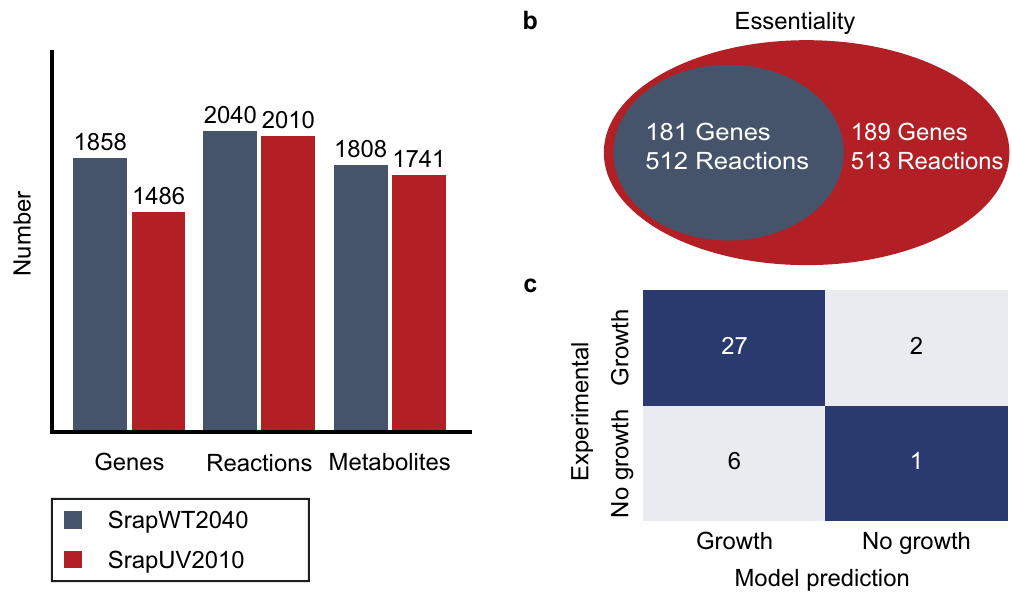
Figure 4. Statistics and simulation results of the genome-scale metabolic models (GEMs) of S. rapamycinicus NRRL 5491 (wild-type) and its mutant SRMK07. ( a ) Number of genes, reactions, and metabolites of the GEMs, SrapWT2040 and SrapUV2010, that represent the wild-type and its mutant SRMK07, respectively. ( b ) Number of essential genes and essential reactions predicted using SrapWT2040 and SrapUV2010. SrapUV2010 was predicted to have eight additional essential genes, and one additional essential reaction in comparison with SrapWT2040. ( c ) The growth prediction results using SrapWT2040 in comparison with the reported growth data that involved 17 individual carbon sources (Supplementary Table S4) and 19 individual nitrogen sources (Supplementary Table S5). It should be noted that SrapUV2010 also generated the same prediction accuracy as